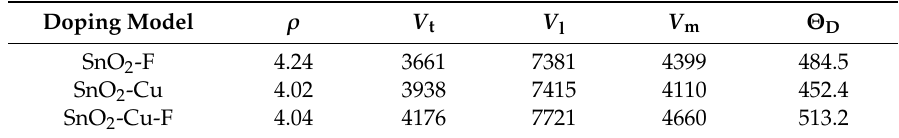
Table 4. Density ρ (g / cm 3 ), transverse wave velocity V t , longitudinal wave velocity V l , average